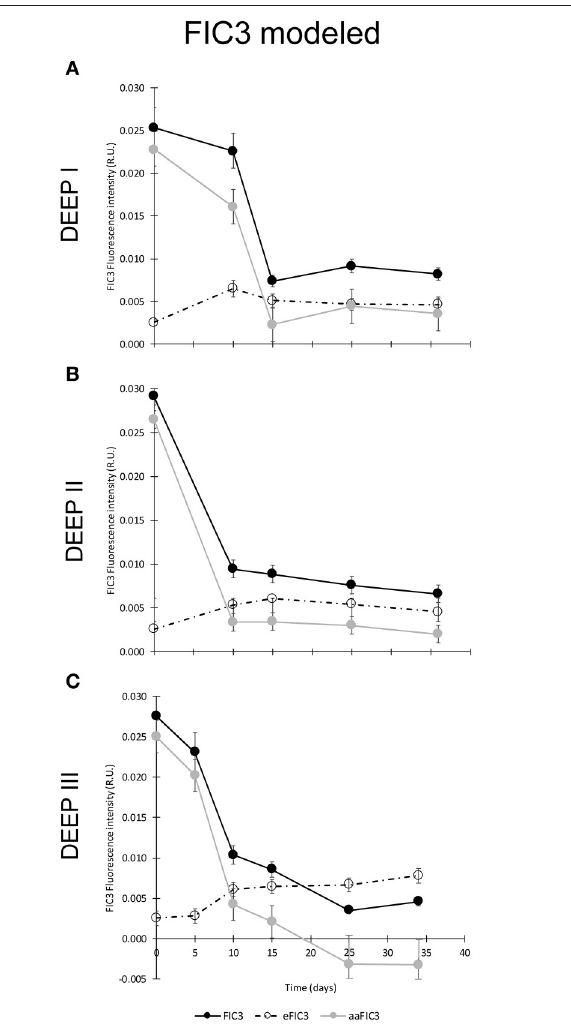
FIGURE 8 | Temporal evolution of: i) observed FIC3 fluorescence intensity (black dots), ii) protein-like fluorescence due to prokaryotic growth estimated following the model described in Figure 7 (eFIC3) (dashed line and empty dots), and iii) fraction of the FIC3 signal due to the amended amino acids (aaFIC3) in CM treatment (gray dots) for experiments DEEP I (A), DEEP II (B), and DEEP III (C). Values expressed in